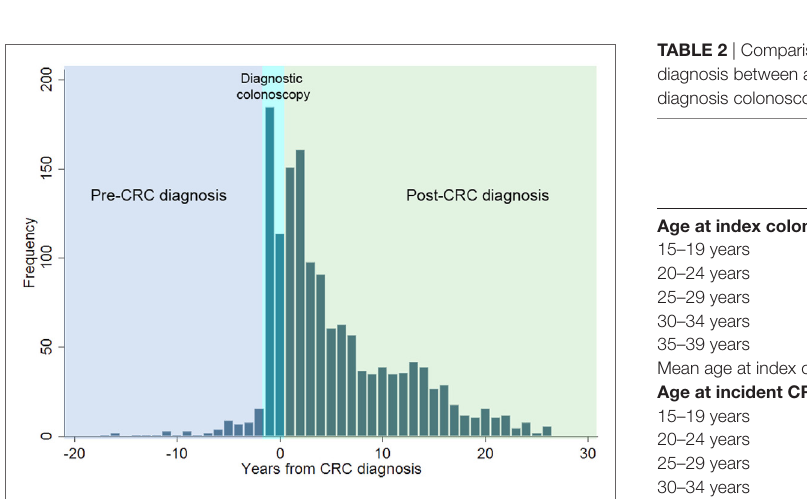
FigUre 2 | Distribution of all colonoscopies performed relative to incident colorectal cancer (CRC) diagnosis in adolescents and young adults in Western Australia during